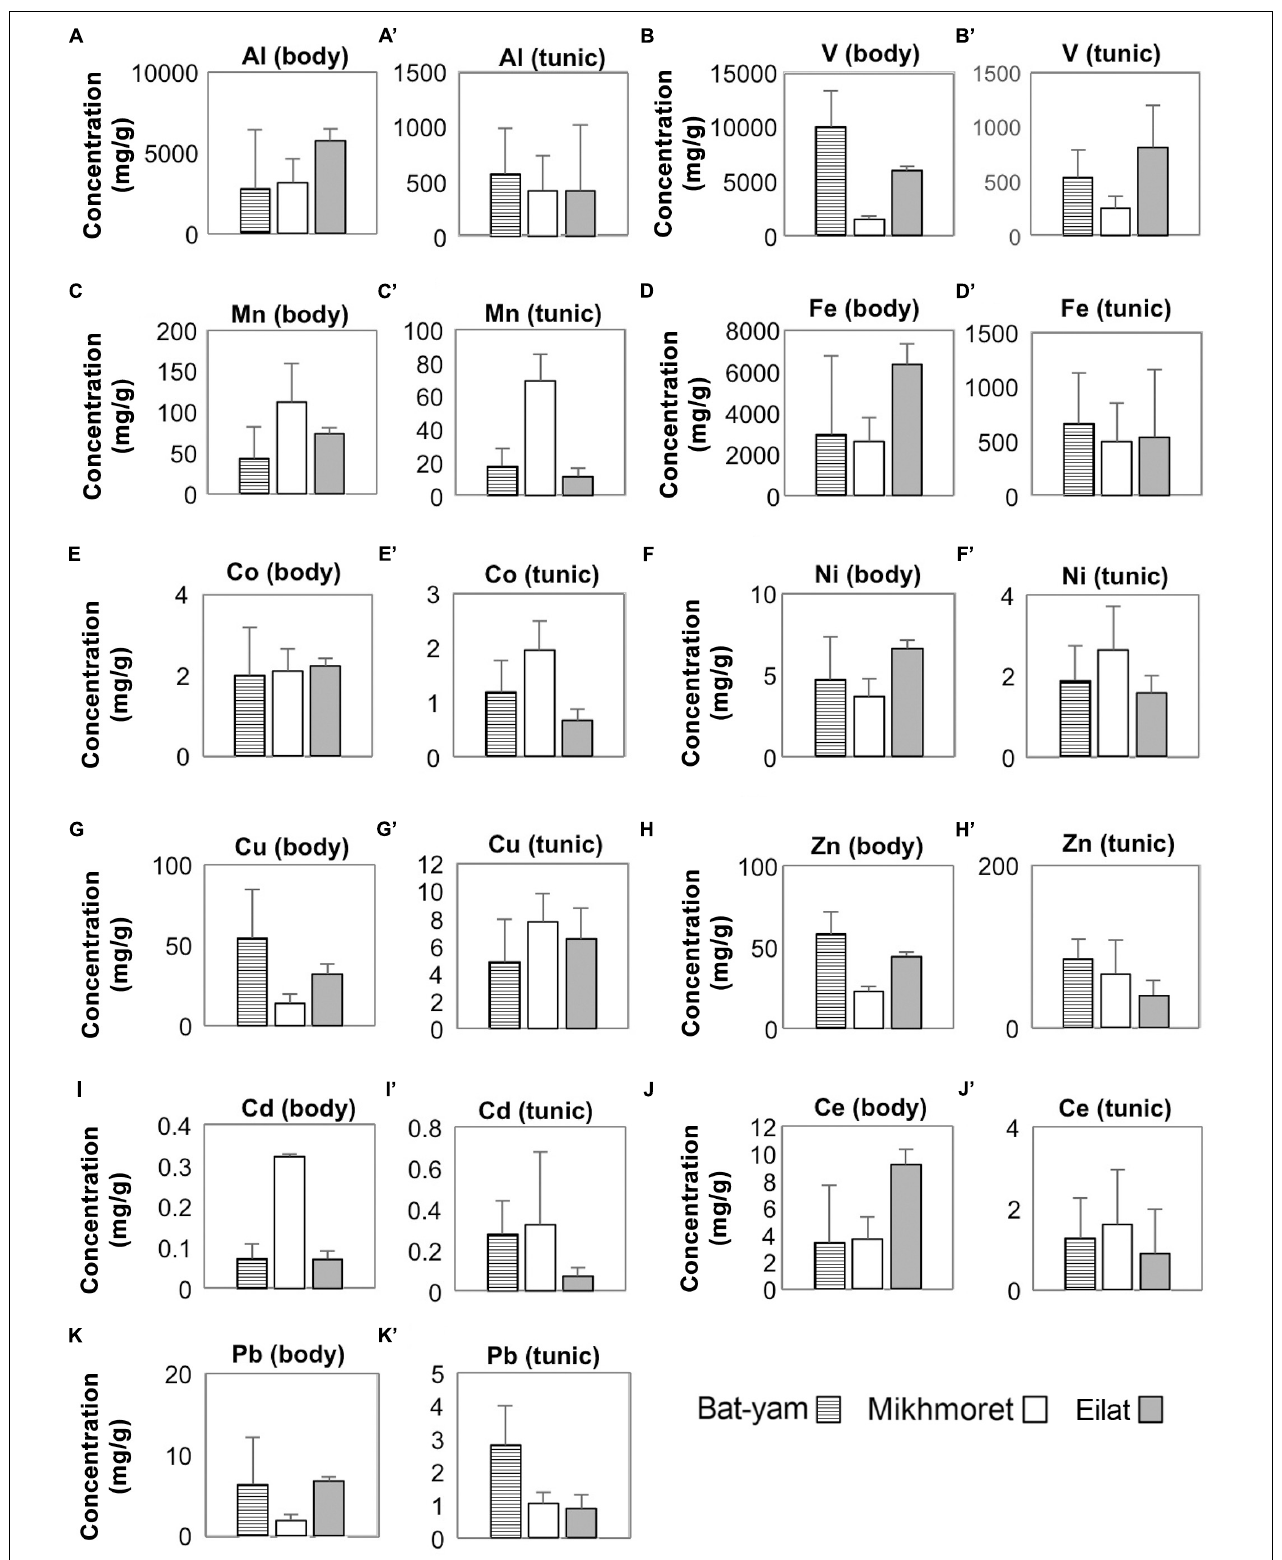
FIGURE 10 | Metal concentrations ( µ g/g) in the bodies (A–K) and tunics (A’–K’) of P. nigra , measured in samples from Bat-Yam, Mikhmoret, and Eilat in spring 2017 (Mean ± SD) ( n = 3–7).